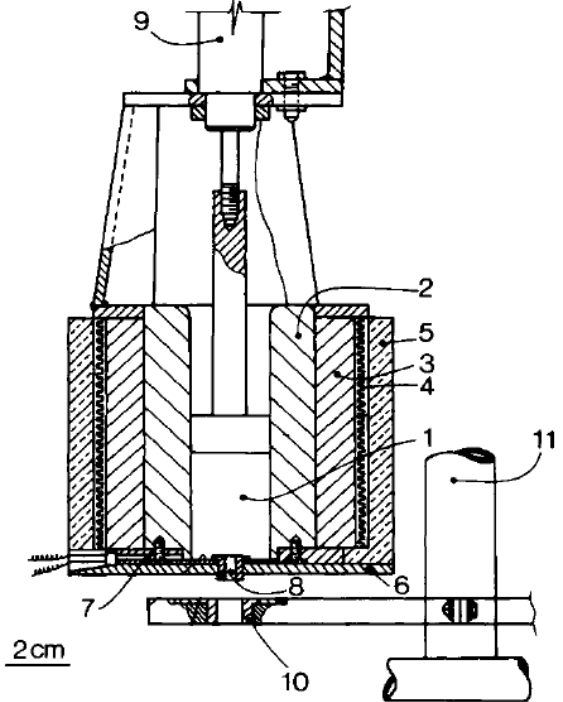
Figure 2. First experimental melt electrospinning setup ( 1 ) chamber, ( 2 ) stainless steel wall, ( 3